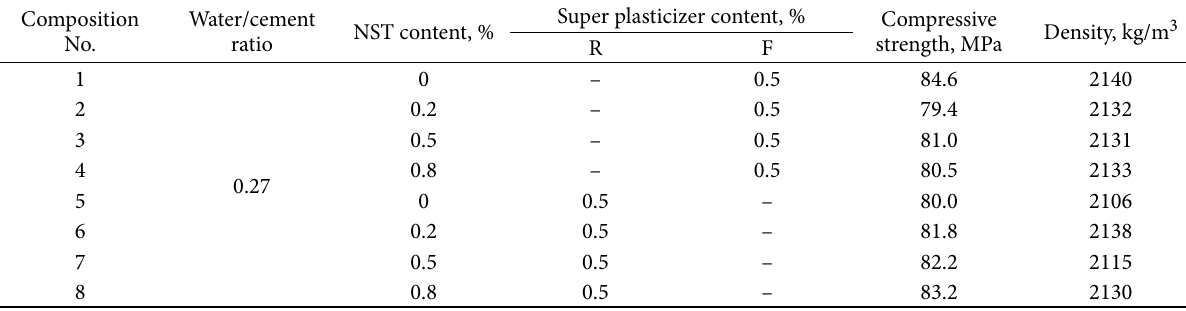
Table 1. The change in compressive strength of hardened cement paste Composition